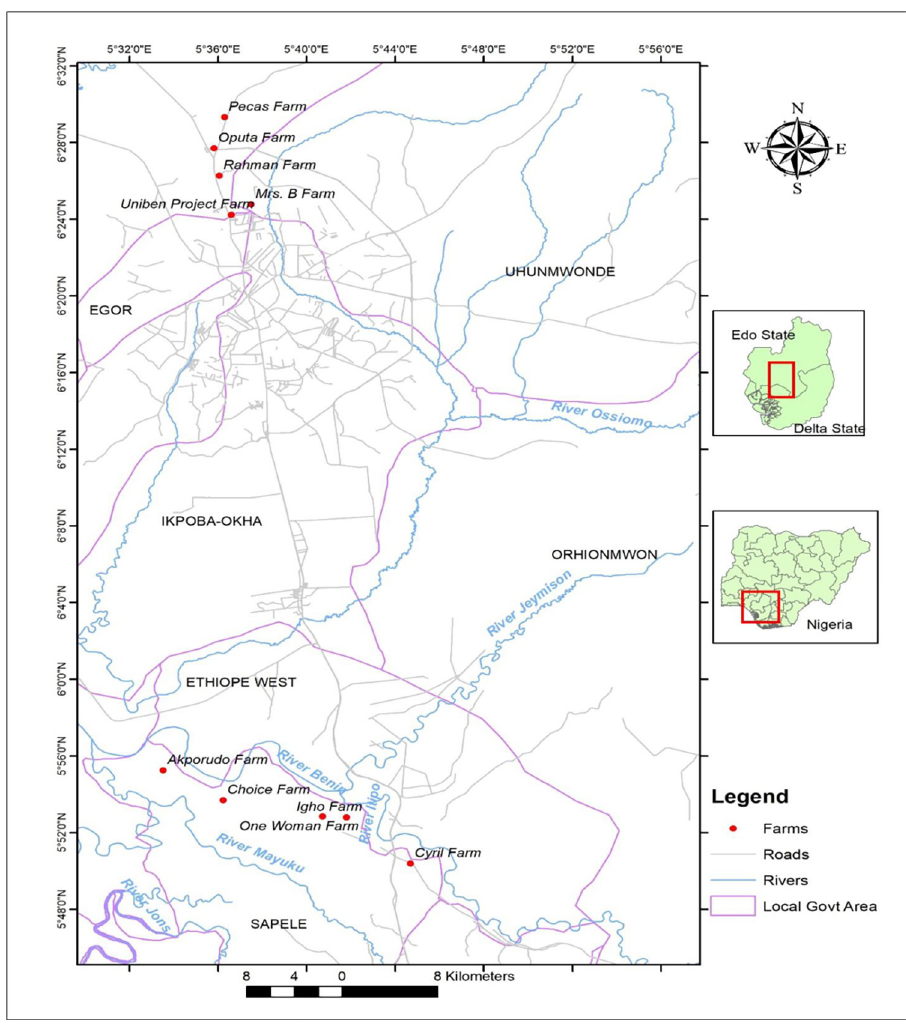
Fig 1. Map of the study